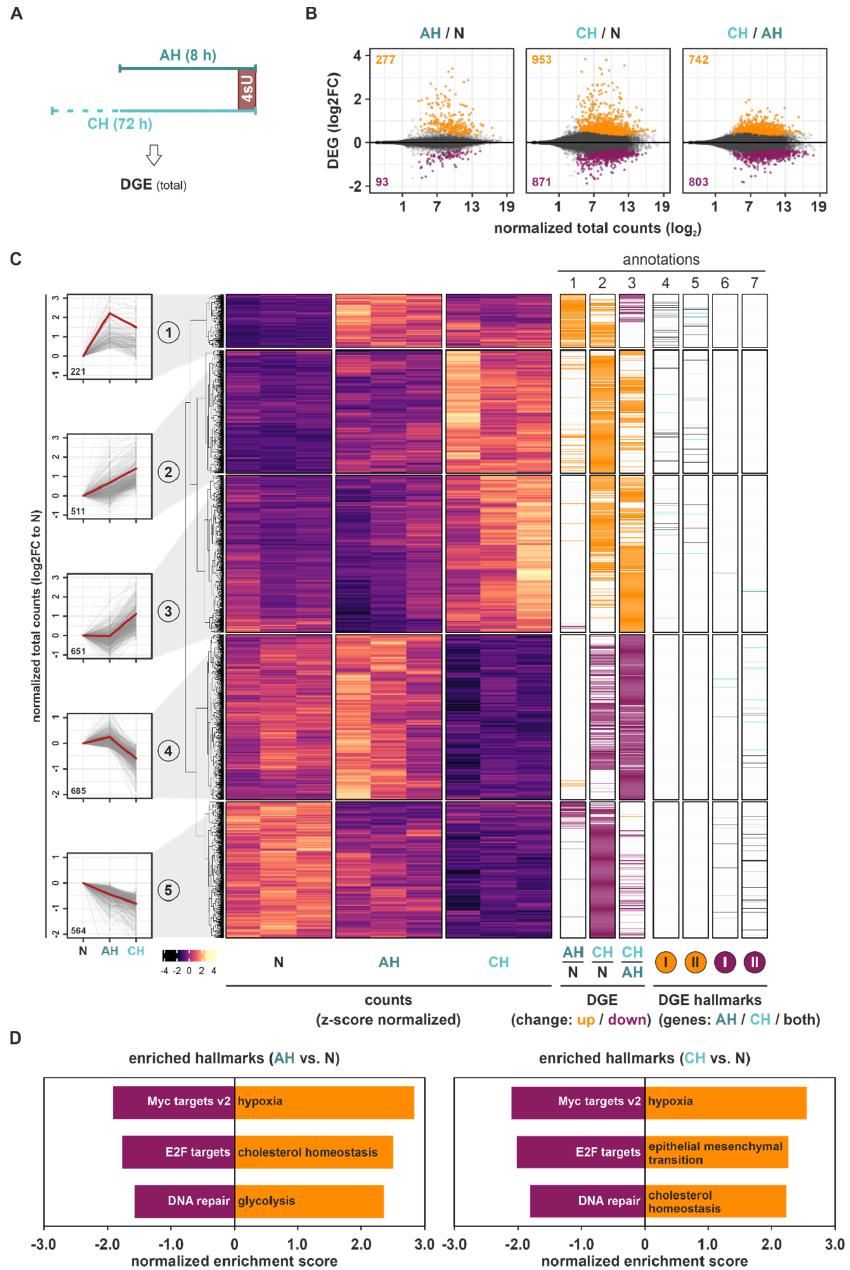
Figure 1. Differential gene expression (DGE) changes under hypoxia. ( A ) THP-1 cells were incubated under hypoxia (1% oxygen) for 8 h (acute hypoxia, AH) or 72 h (chronic hypoxia, CH), or under normoxia, supplemented with 300 µM 4-thiouridine (4sU) for the last hour. DGE changes were determined based on changes in total read counts. ( B ) MA plots representing DGE changes (log2FC) between AH and N ( left ), CH and N ( middle ), or CH and AH ( right ). Significant DGE targets (padj < 0.05) are indicated in orange (up) or purple (down). ( C ) Heatmap representing z -score-normalized counts of all DGE targets significantly altered in at least one of the comparisons. Five groups representing different DGE dynamics were identified by k -means clustering analysis ( left panels ). Annotation columns 1–3 depict DGE changes (up: orange; down: purple) for the